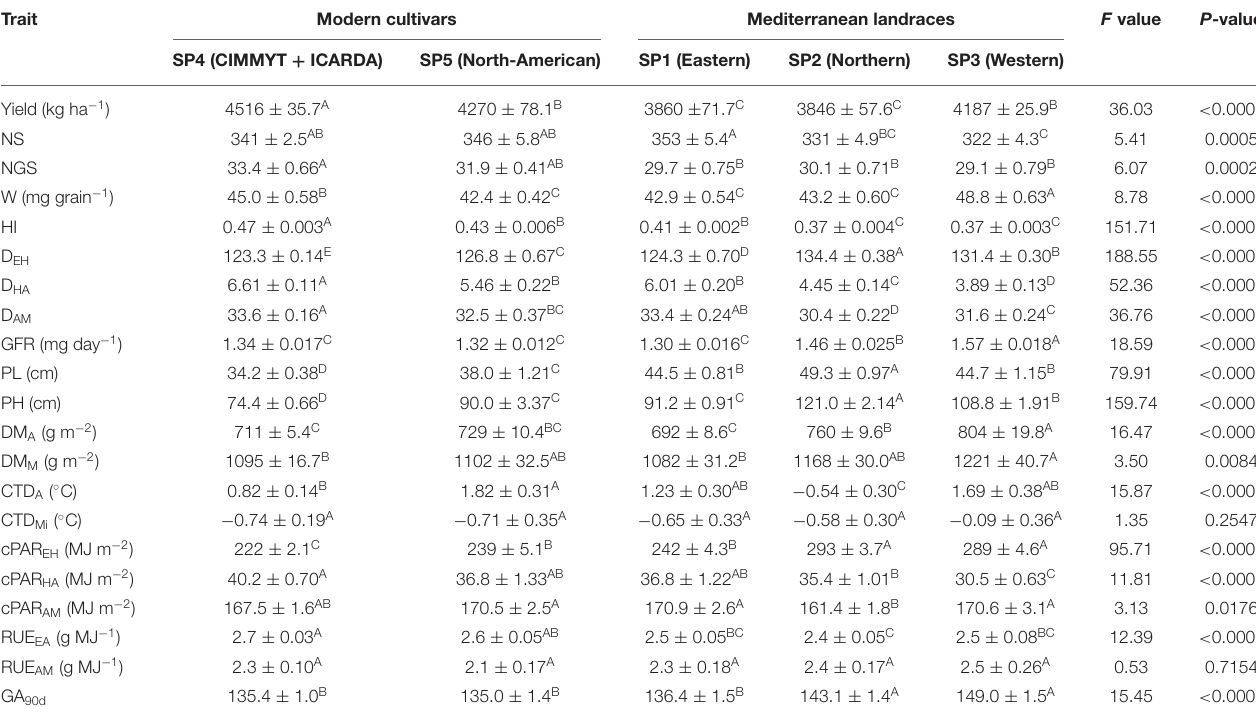
TABLE 3 | Analyses of variance and mean values ± SE for the studied traits on durum wheat Mediterranean landraces and modern cultivars with a membership coefficient q > 0.80 to five genetic subpopulations (SP). Trait Modern cultivars Mediterranean landraces F